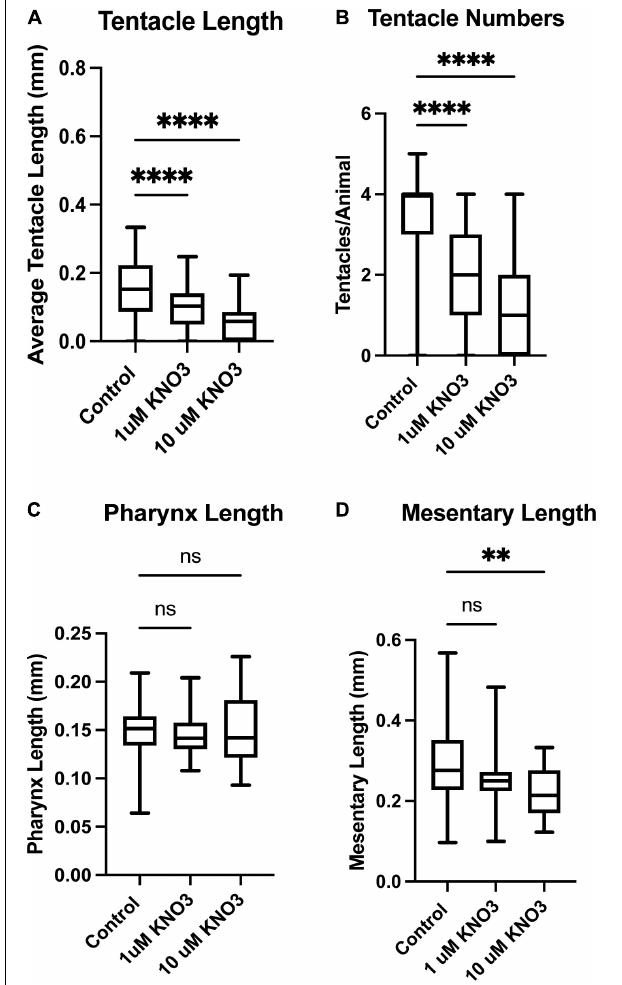
FIGURE 3 | Exposure to Potassium Nitrate leads to defects in tissue development. Animals exposed to 1 or 10 µ M KNO 3 have much shorter tentacles (A) and developed fewer tentacles when compared to control animals (B) . The length of pharynx was also measured but no significant difference was found in overall length in comparison to sibling control animals (C) . The overall length of the mesenteries was also found to be shorter in animals exposed to phthalates (D) . Control n = 72, 1 µ M n = 66, 10 µ M n = 68, ∗ p ≤ 0.05, ∗∗ p ≤ 0.01, ∗∗∗ p ≤ 0.001, N.S. is not